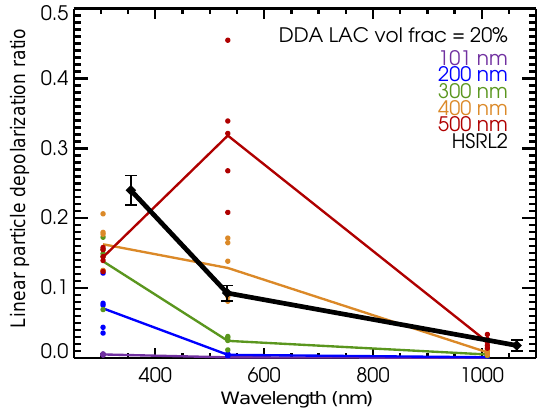
Figure 15. The linear particle depolarization ratio at three wave- lengths for soot aggregates embedded in a sulfate shell reproduced from Kahnert et al. (2012), for 20% LAC volume fraction. Dots indicate five realizations with randomly generated geometries, per aggregate volume-equivalent particle radius. The colored lines con- nect the averages of the five for each wavelength. The legend shows the aggregate volume-equivalent particle radii at which the calcula- tion was performed. The thick black line indicates the particle de- polarization ratios measured by airborne HSRL-2 within a smoke plume observed on 17 July 2014 at 355, 532, and